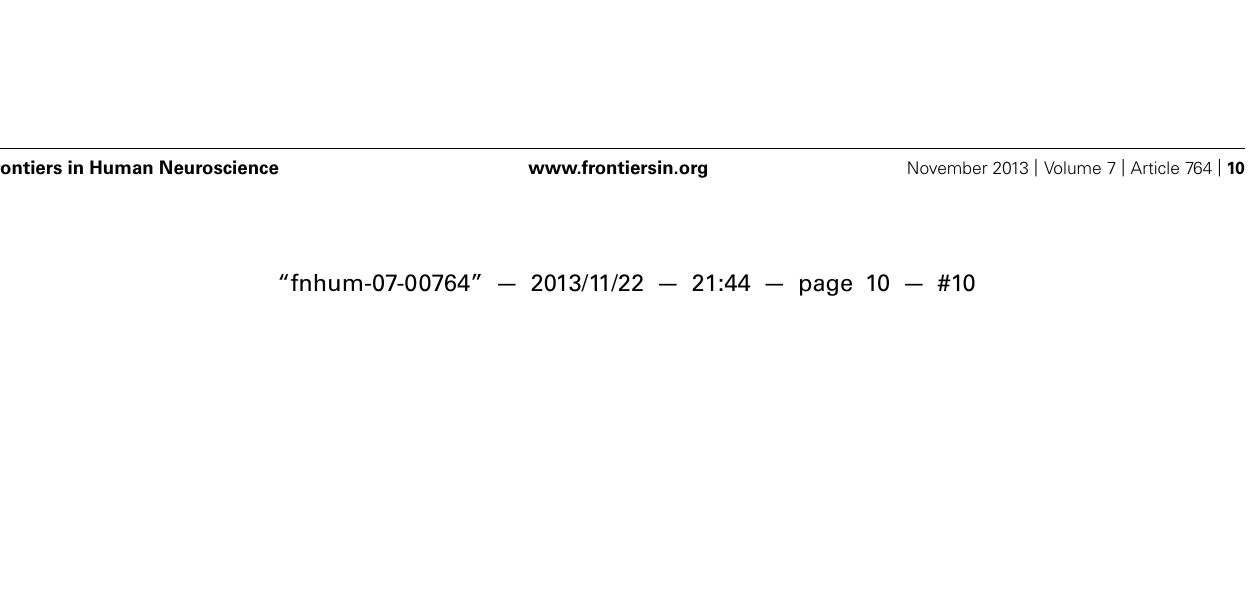
Frontiers in Human